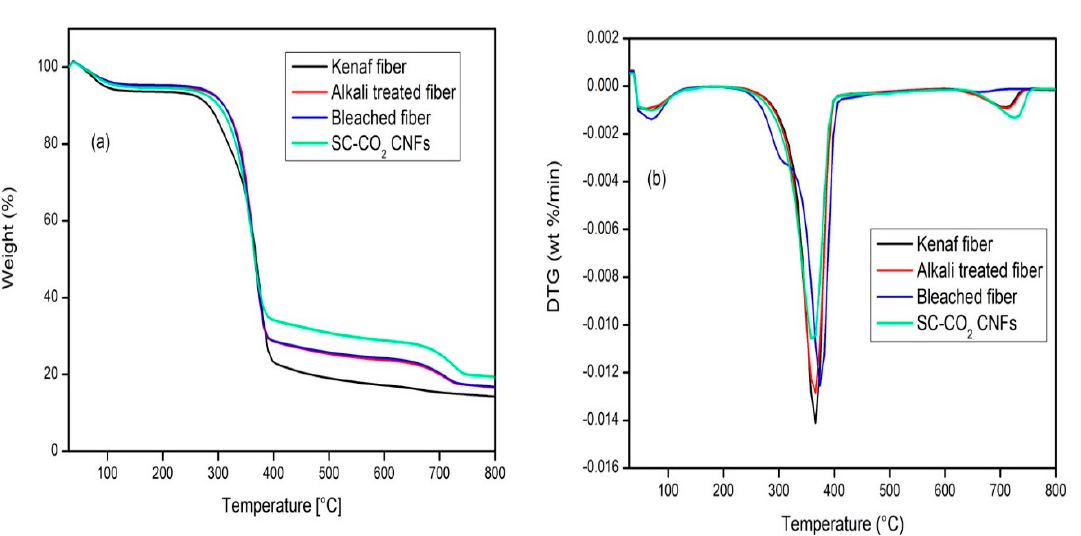
Figure 6. ( a ) TGA and ( b ) DTG curves of raw kenaf fiber, alkali treated fiber, bleached fiber, and SC-CO 2 extracted CNFs.